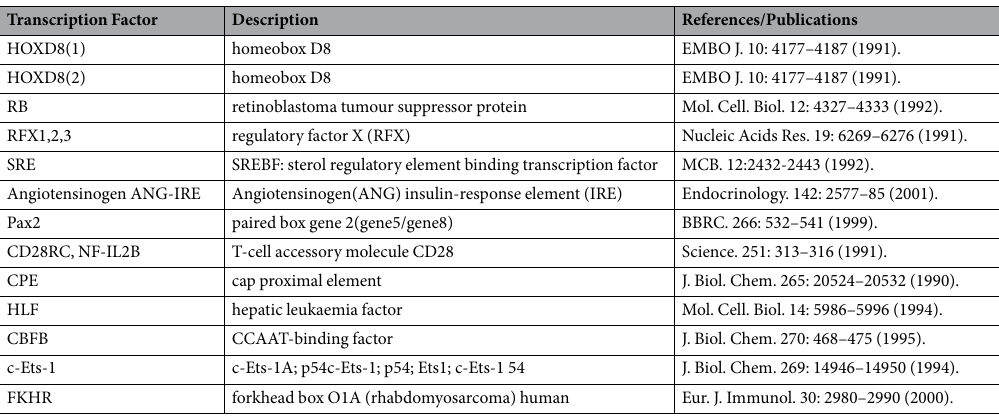
Table 1. Detailed information of 13 common